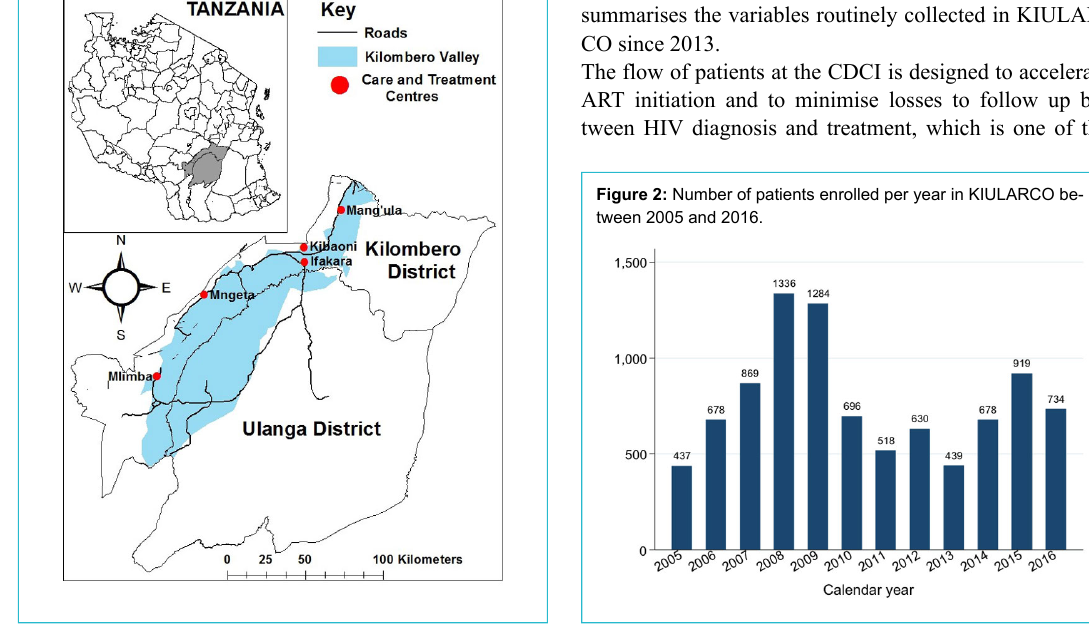
Figure 1: Catchment area of KIULARCO, Kilombero and Ulanga Districts (ArcGIS software, ESRI, USA).